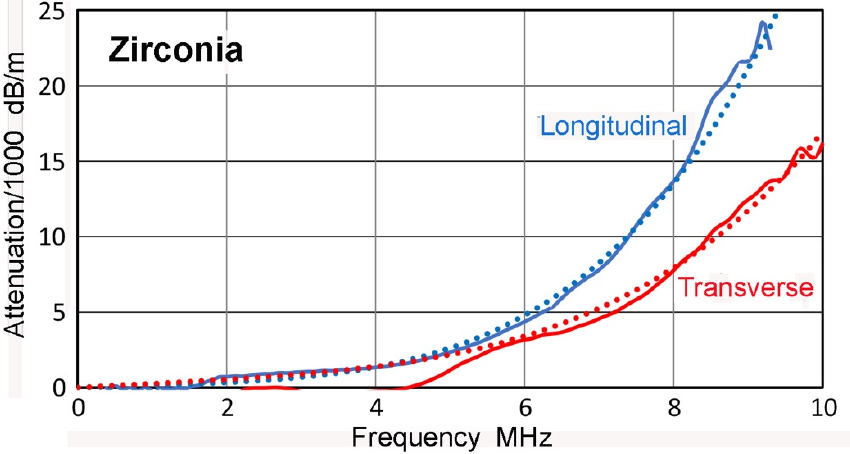
Figure 9. Attenuation (dB/m) vs. frequency, f (MHz) for yttria ‐ stabilized zirconia. Blue solid and dotted curves are for the observed and Mason ‐ McSkimin ‐ fitted longitudinal attenuation and red solid and dotted curves are for the corresponding transverse attenuation. Table 4. Elastic constants of hard ceramics.